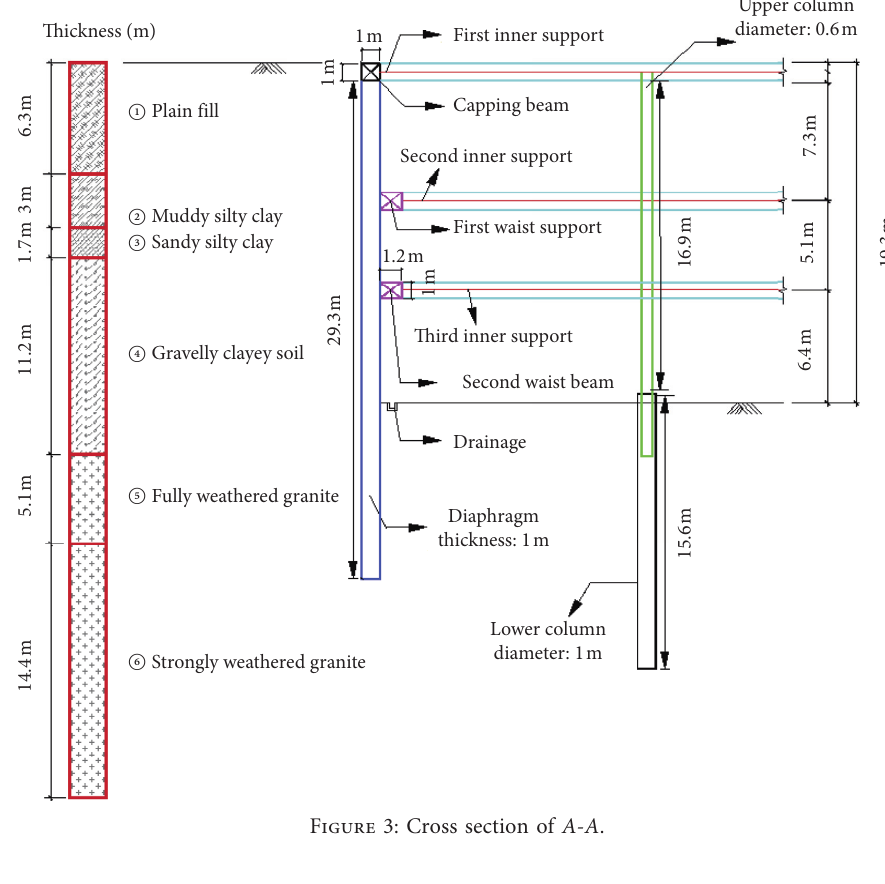
Figure 3: Cross section of A - A